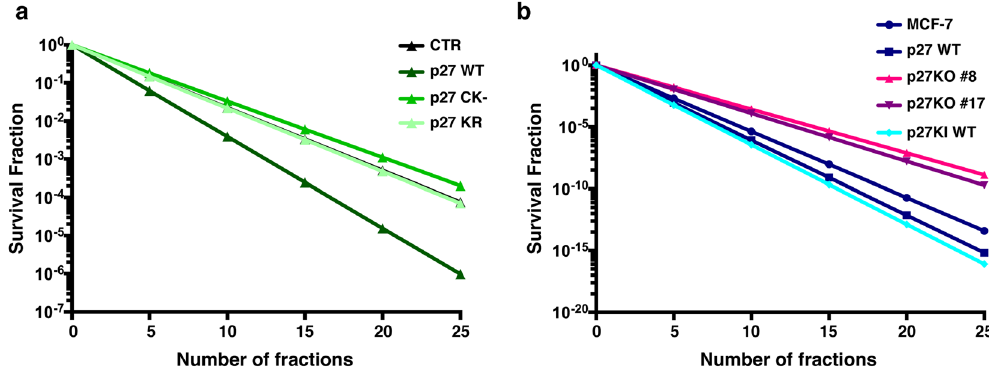
Figure 7. Fractionation effect on cell survival. ( a , b ) Graphs report the hypothetical model curves for final surviving fraction of murine 3T3 ( a ) and human MCF-7 ( b ) cell lines that are isogenic for p27. The model was calculated using the survival fraction data obtained in the cell lines after a single dose of 2 Gy to estimate the survival fraction after a 50 Gy of fractionated treatment. Final surviving fraction after 25 treatments of 2 Gy can be anywhere between two (in 3T3 fibroblasts, proficient or deficient for p27) or five logs (human MCF-7 breast cancer cells deficient or proficient in p27 expression) of cell kill